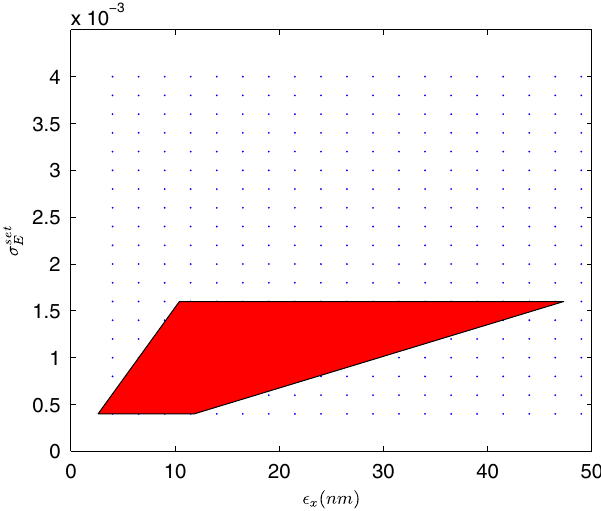
¼ 40 ; 45 ; 50 nm . x